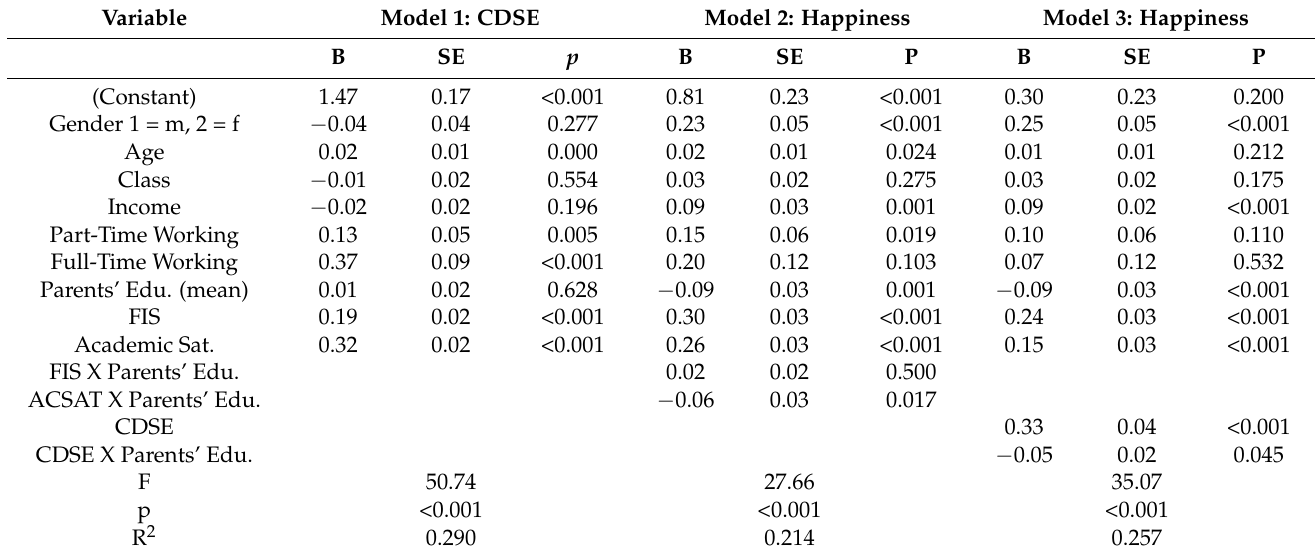
Table 3. Main effects on dependent